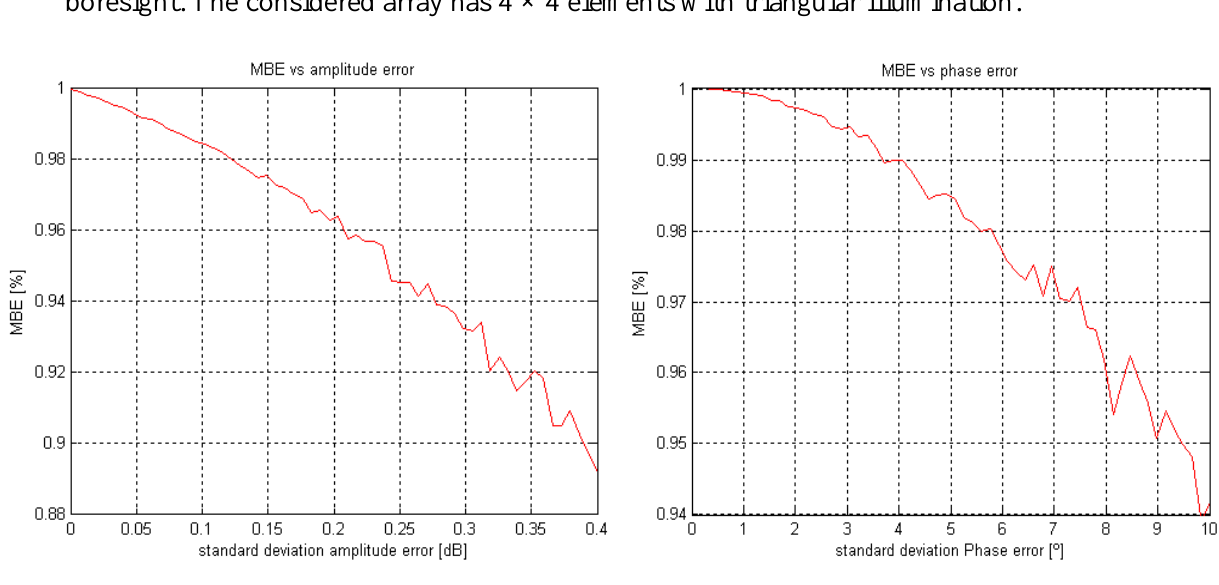
Figure 3. Degradation of the MBE vs. the amplitude (left) and phase (right) residual calibration error, obtained using theoretical development and simulations, pointing to the boresight. The considered array has 4 × 4 elements with triangular